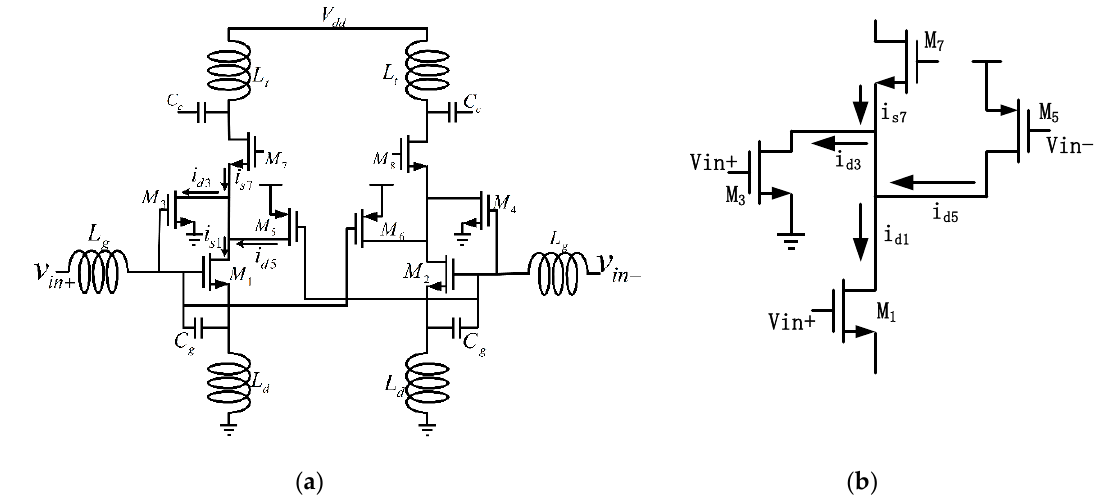
Figure 2. Schematic diagram of the proposed: ( a ) LNA (low noise amplifier); and ( b ) current flow of the left half-circuit.